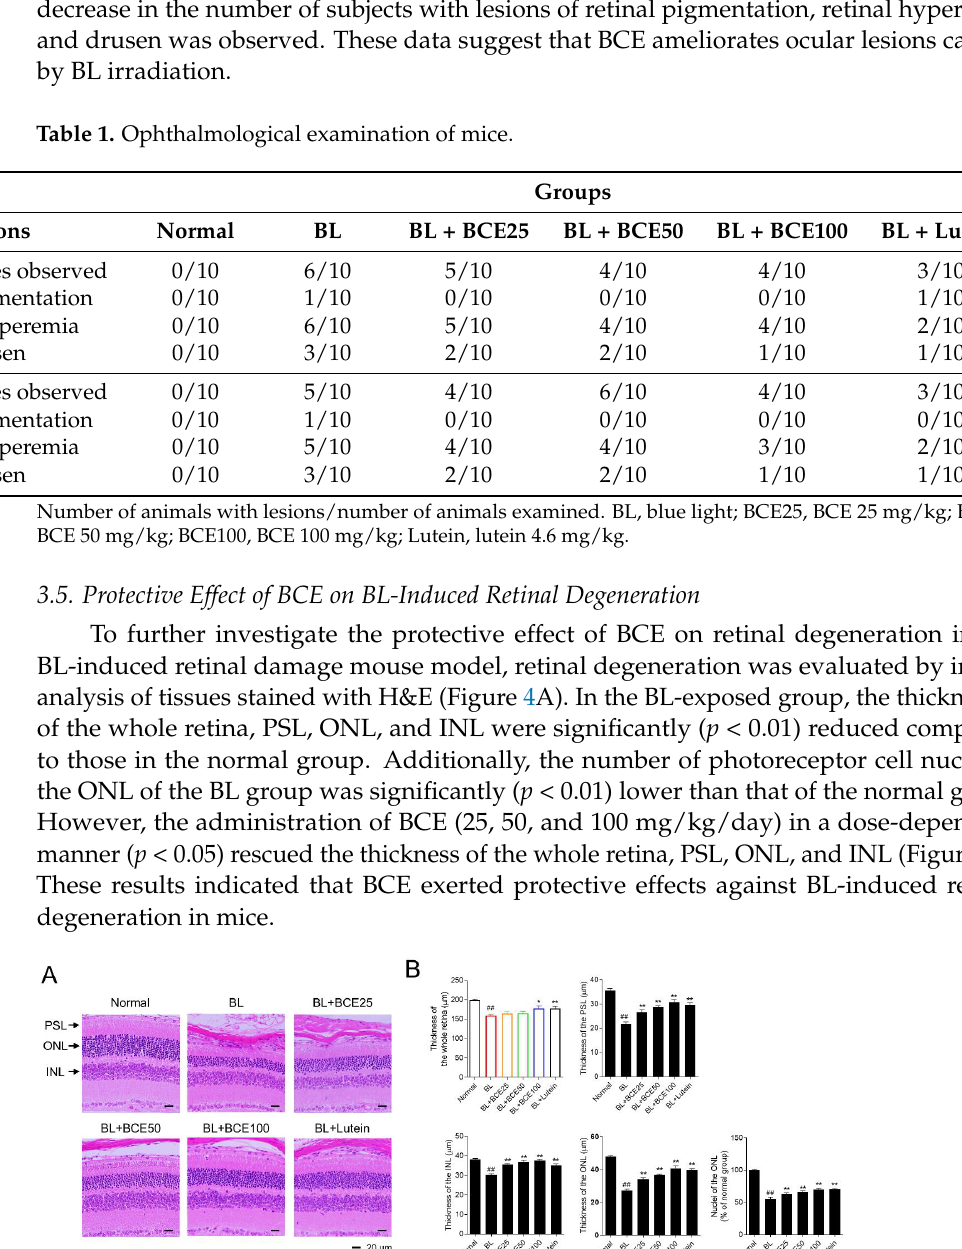
Table 1. Ophthalmological examination of mice.